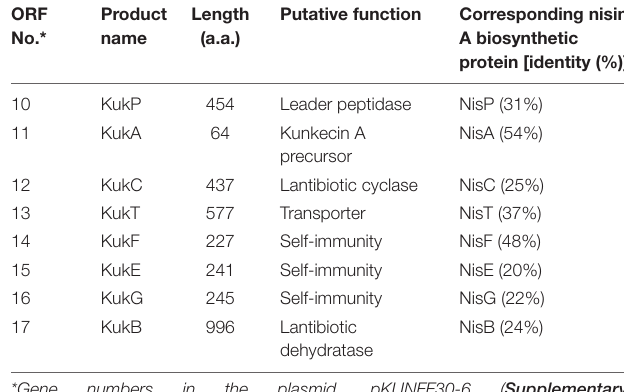
TABLE 1 | Putative kunkecin A biosynthetic proteins encoded on genes identified in the plasmid, pKUNFF30-6, harbored by A. kunkeei FF30-6. ORF